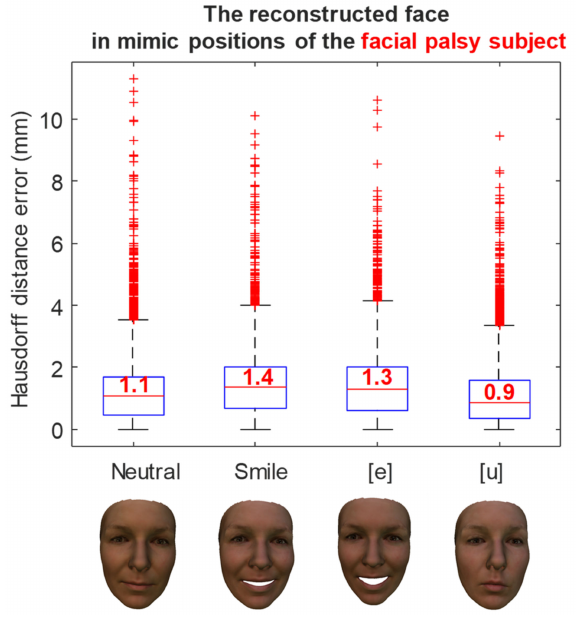
Figure 12. The error of the reconstructed face in mimic position of a facial palsy subject.